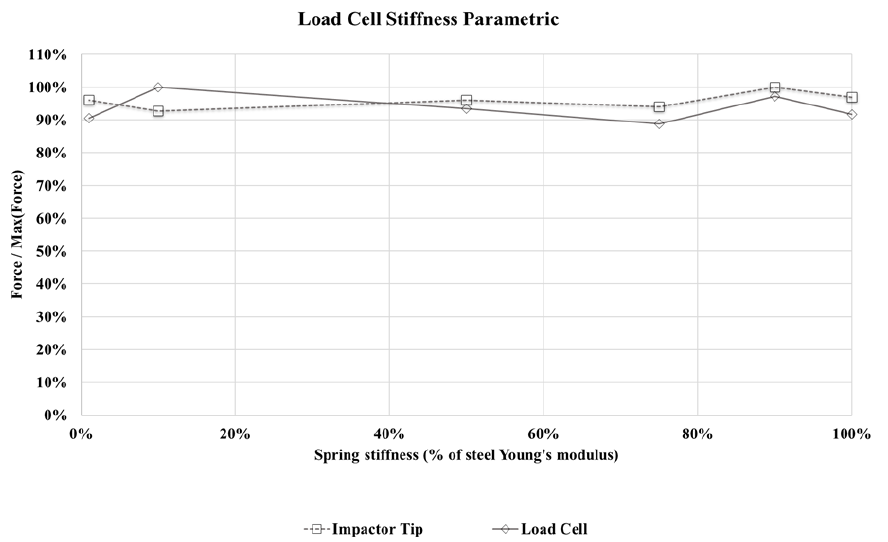
Figure 9. Force measurements parametric studies in both load cell and impactor model positions, normalized by maximum measurement for each case.